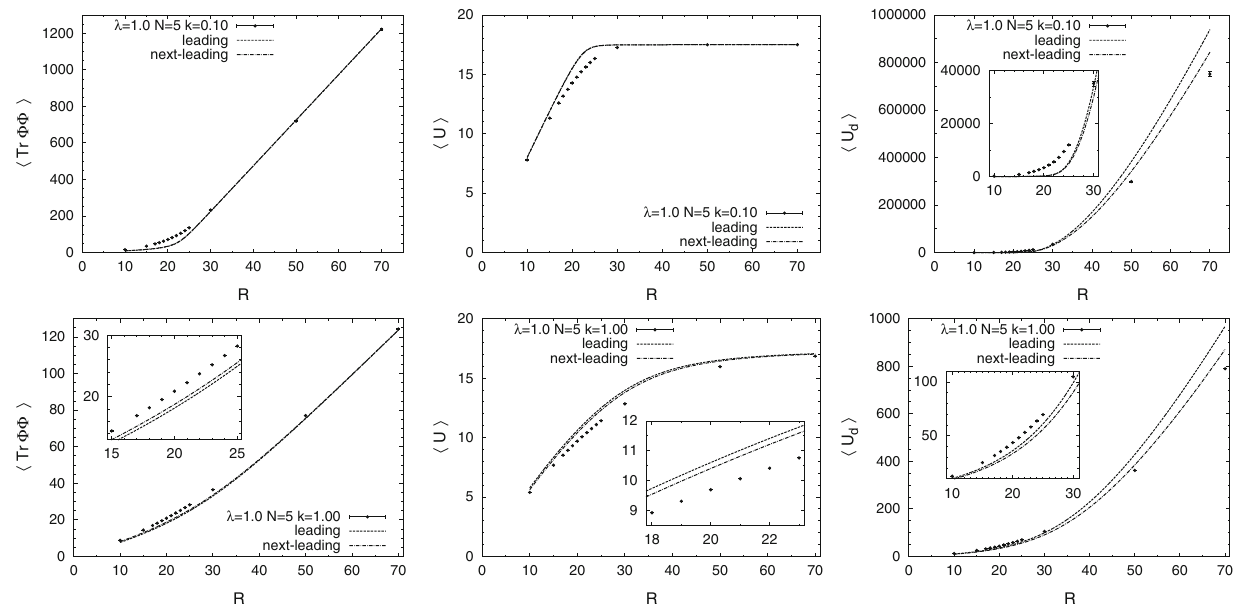
Fig. 3 The numerical results of e.v. of the observables discussed in leading orders, respectively. There are some small windows within the Sect. 3 for λ = 1, N = 5 and k = 0 . 1 (top three) and k = 1 . 0 (bot- figures, where one can see which of the leading and next-leading lines tom three) against R . Plotted points represent the Monte Carlo results existsabove/belowtheother,andcanalsoseemoreclearlytheresultsfor (cid:9) in the transition region around R = R (cid:8) U and ‘leading’ and ‘next-leading’ mean the evaluations based on Eq. d c . For the clarity of the small ( t ) in the leading and next- R regions, which are unclear in some of the figures, we provide Fig. 4 (12) with perturbatively evaluated f N , R ,λ,λ d Fig. 4 Magnification of the small R regions that are unclear in Fig. 3